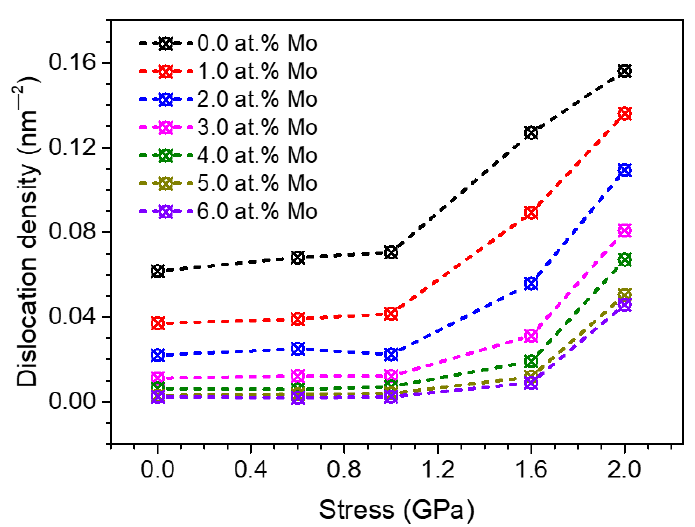
Figure 10. Relationship between the dislocation density and the applied stress in segregated Ni-Mo samples with different Mo concentrations after creep at 1100 K for 200 ps, the situation of stress at 0 GPa represents the dislocation density of the equilibrium configuration at 1100 K.